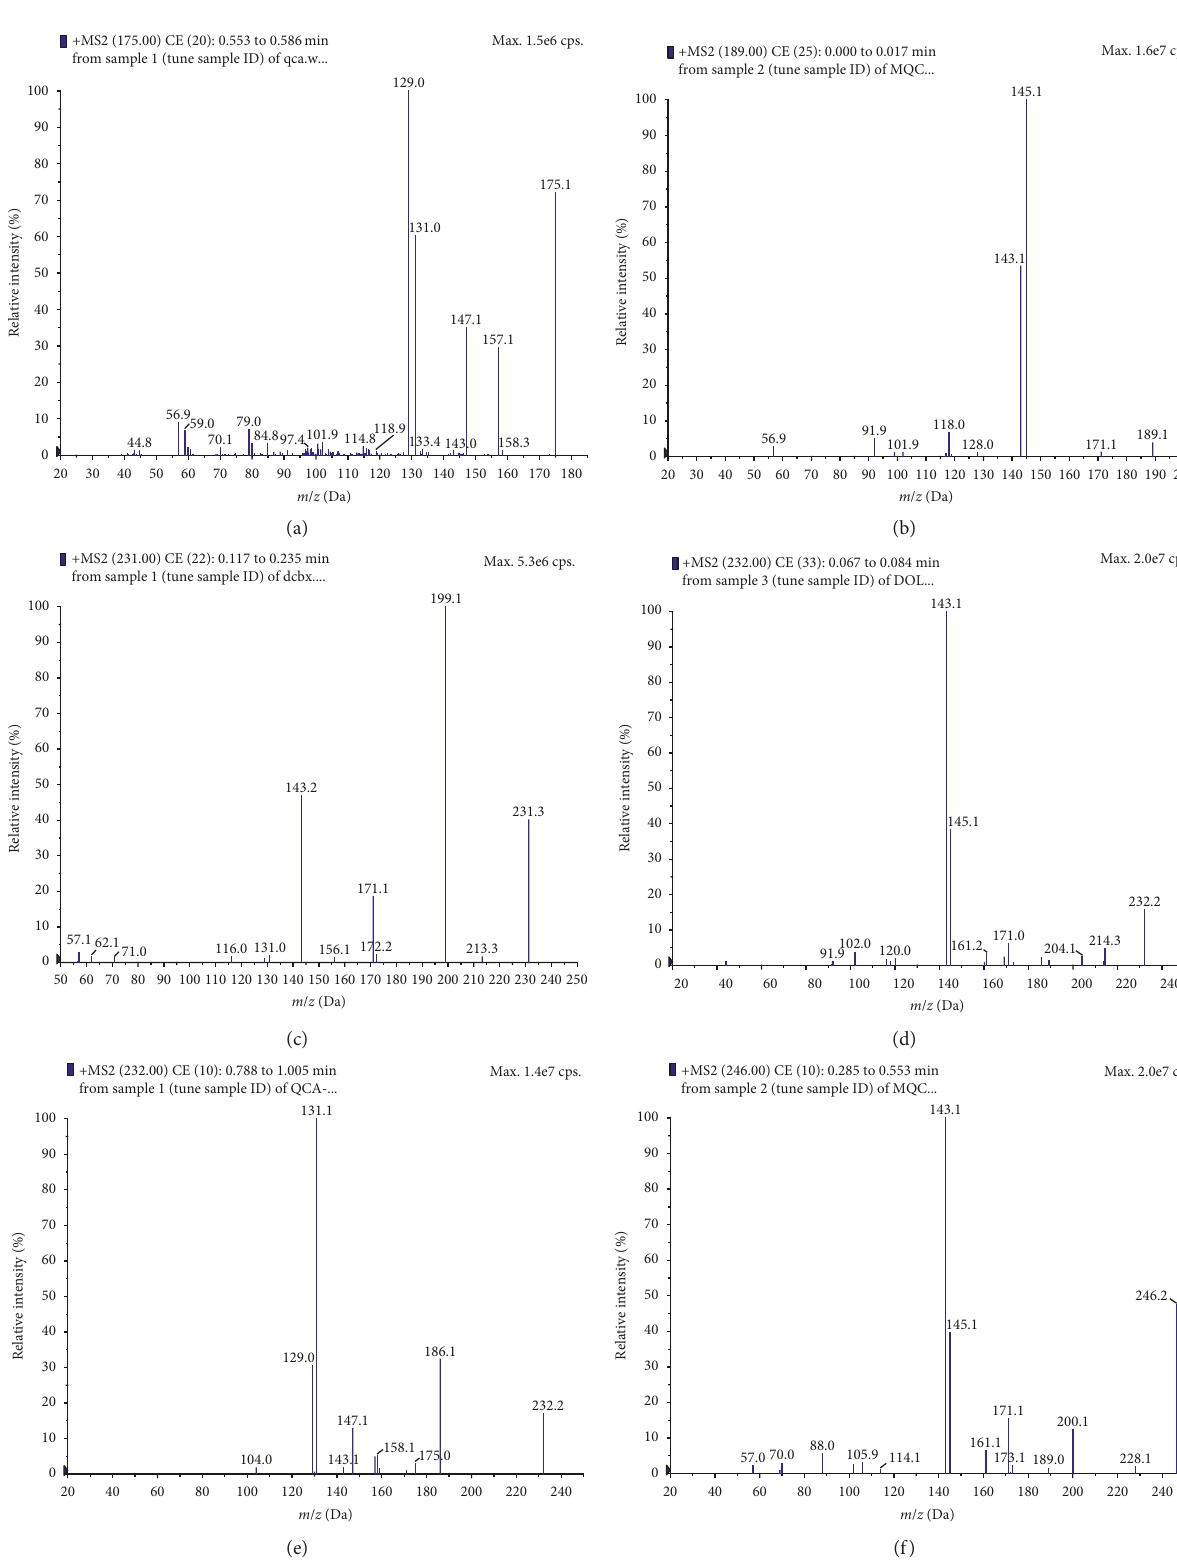
Figure 1: Mass spectra of (a) QCA, (b) MQCA, (c) DCBX, (d) DOLQ, (e) QCA-glycine, and (f)